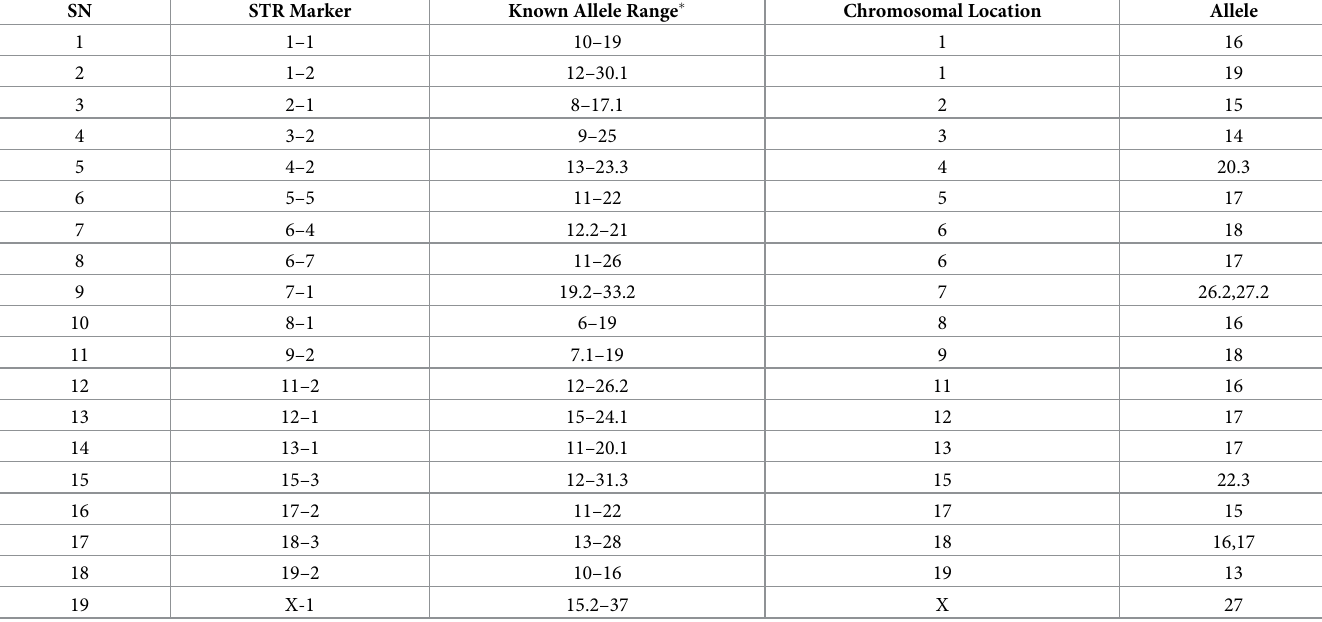
Table 2. Short tandem repeat (STR) marker profile of Col-GFP HSC.